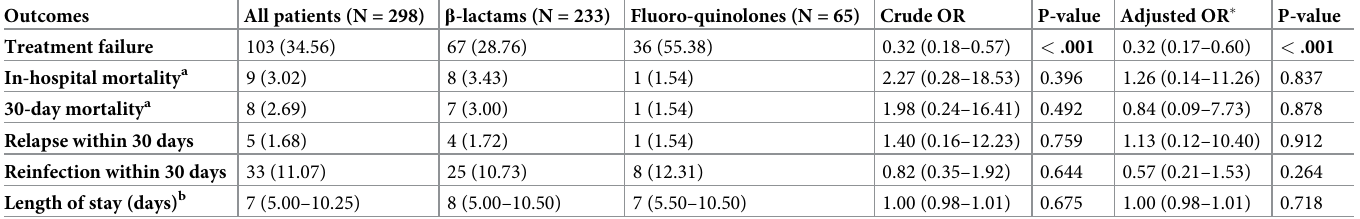
Table 2. Outcomes of the cohort in different empirical